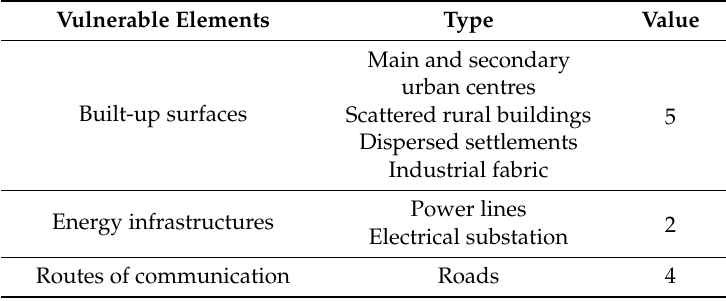
Table 7. Factors for vulnerability estimation.